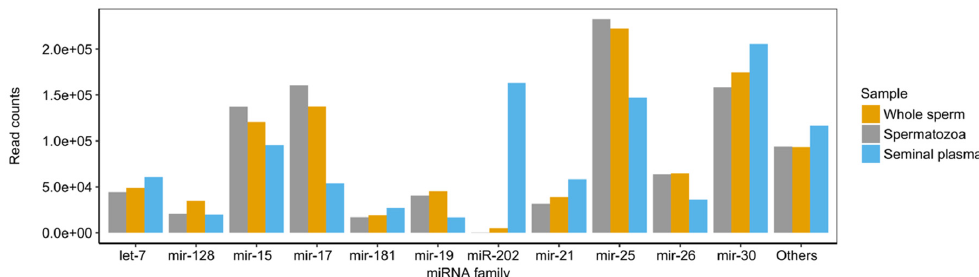
Figure 3. The most dominant miRNAs in the whole sperm and its fractions (spermatozoa and seminal plasma) of the Atlantic salmon.